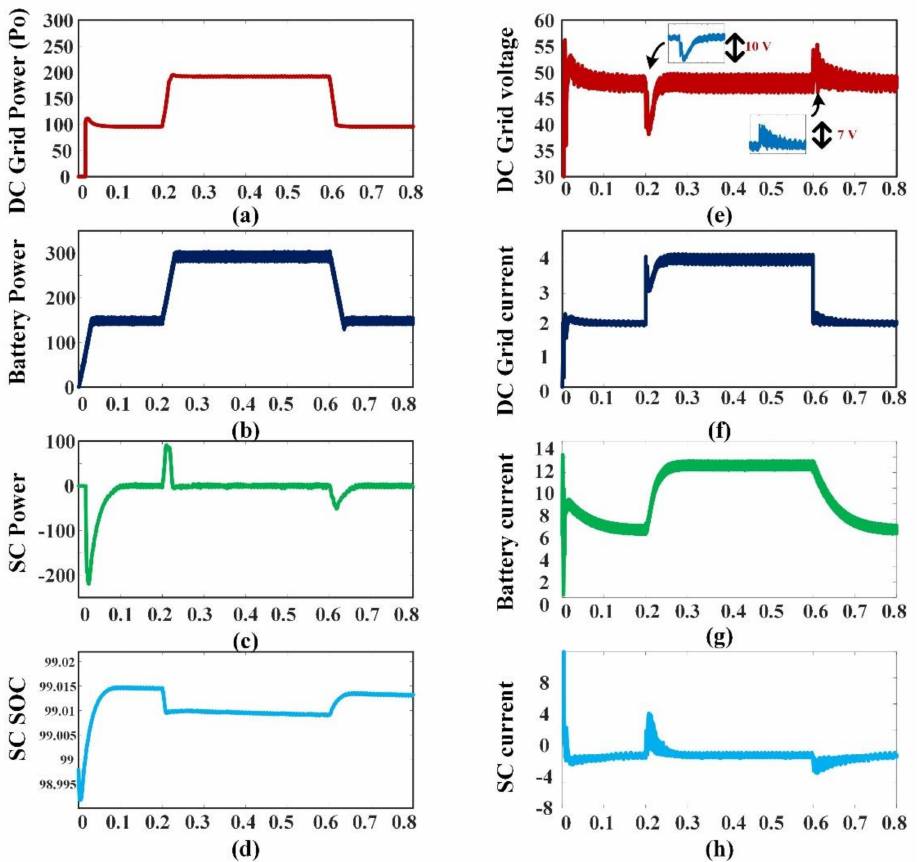
Figure 13. The simulation findings for a change in load demand are as follows: ( a ) DC microgrid power, ( b ) battery storage power, ( c ) SC storage power, ( d ) SC SOC, ( e ) DC microgrid voltage, ( f ) DC microgrid current, ( g ) battery storage current and ( h ) SC storage